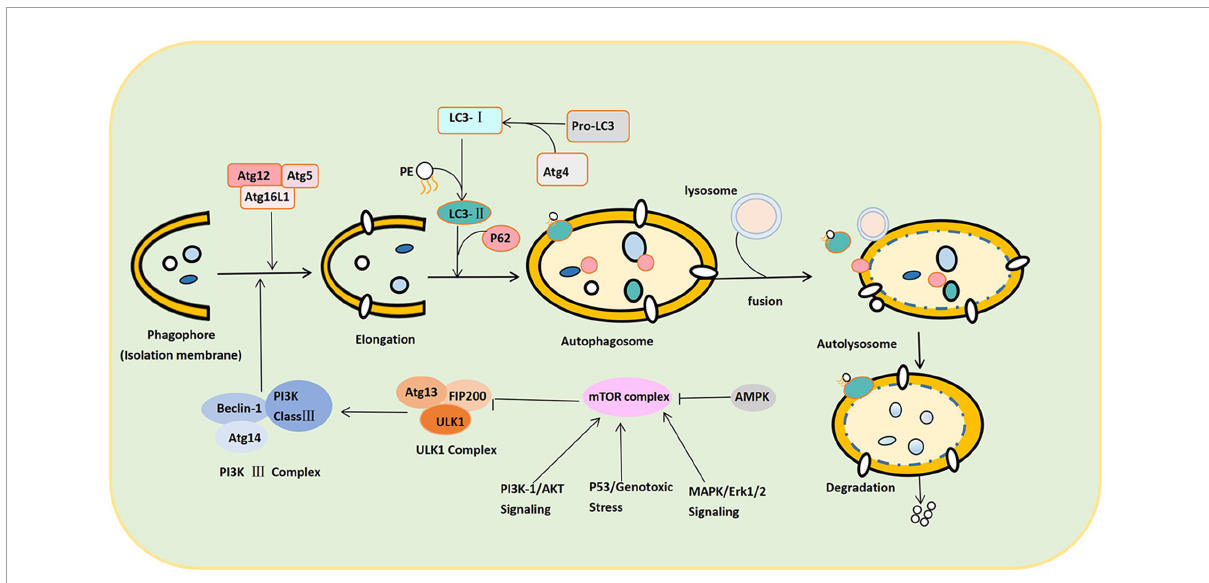
FIGURE2 Schematic illustration of the autophagy process. The autophagy process can be divided into the following stages: Induction, nucleation of phagosomes, elongation of phagosomes, completion of autophagosomes, fusion with lysosomes to form autophagosomes, and content degradation. After LC3 binds to phospholipid ethanolamine (PE), LC3-II is anchored to the cell membrane, promoting the expansion and closure of phagosomes and finally forming autophagosomes. P62 links LC3-II to the substrate on the isolation membrane and separates the isolation substrate. In response to SNARE proteins, both ends of the sequestration membrane close and form a complete autophagosome with a bilayer structure. The autophagosome and lysosome fuse to form the autophagolysosome. Under the control of lysosomal-associated membrane proteins, the autophagy outer membrane fuses with the outer lysosomal membrane to form an autophagolysosome. Autophagolysosome degrades the substrate into small molecules such as lipids, nucleosides, and other substances used by the